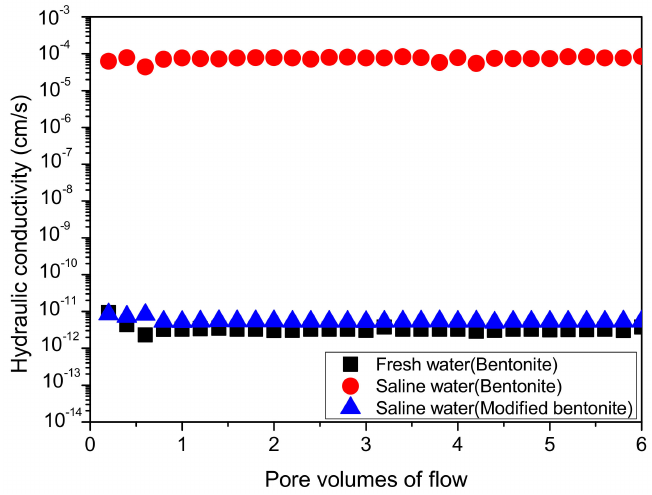
Figure 16. Hydraulic conductivity of NB in fresh water and MB in fresh and saline water